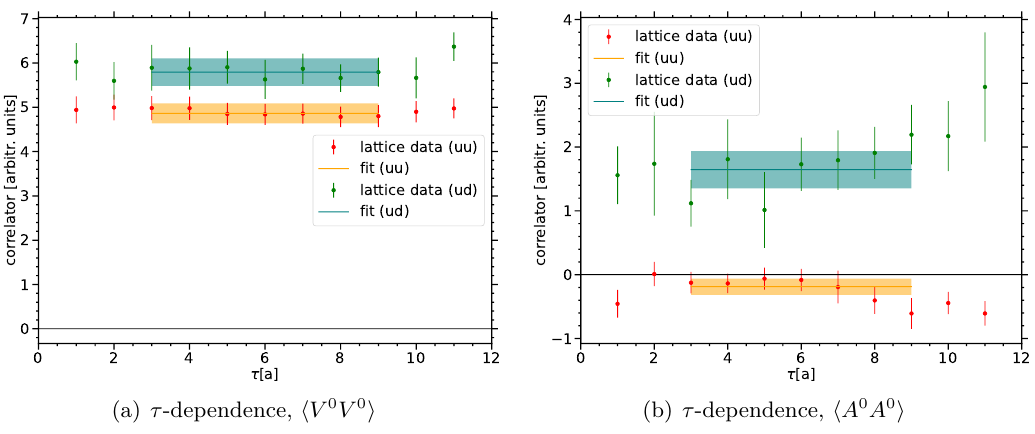
Figure 6 . τ -dependence of the C 1 contraction for the two flavor combinations uu and ud . This is plotted for h V 0 V 0 i (a) and h A 0 A 0 i (b) for fixed ~y = ( − 3 , 4 , 3) at momentum ~p = ~ 0